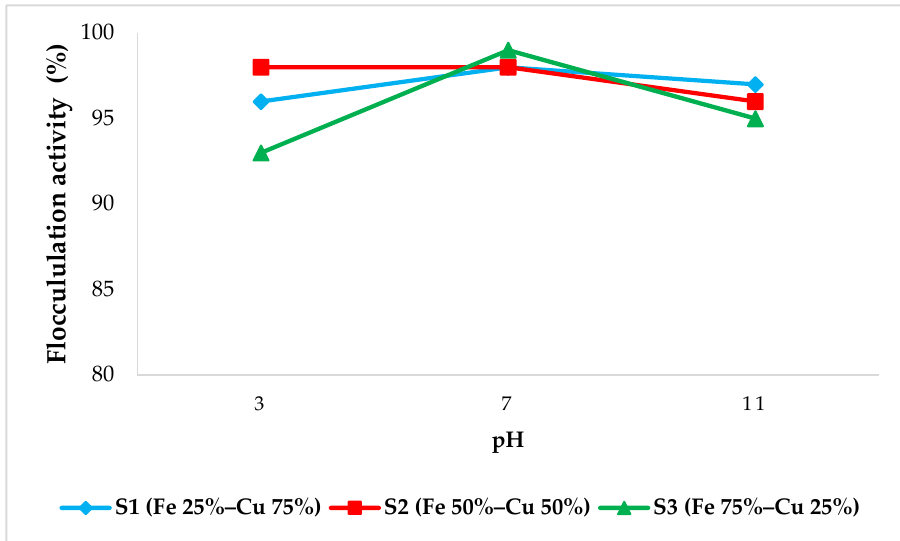
Figure 5. pH effect on the flocculation activity of nanoparticle samples S1, S2, and S3.